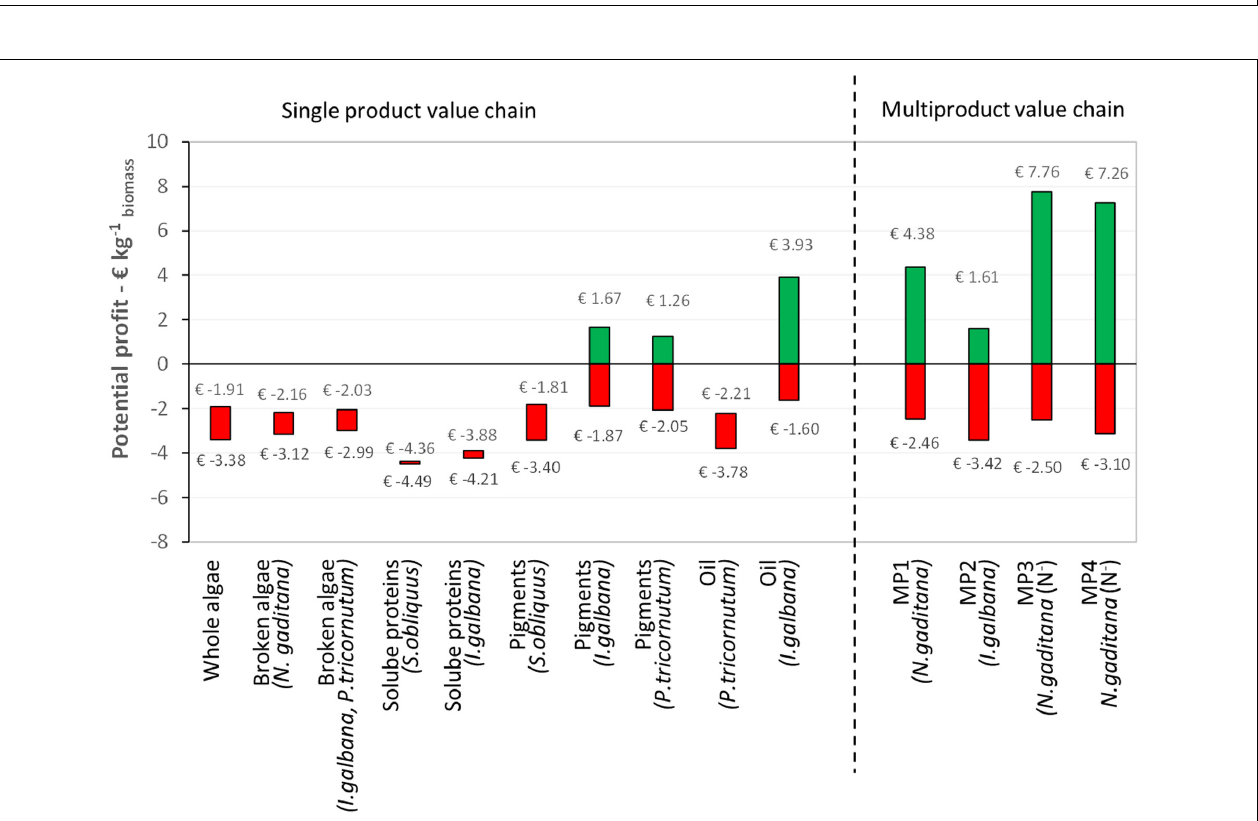
FIGURE 9 | Potential profit expressed per unit of initial biomass for the single and multiproduct value chains at 10 ktons y - 1 scale, based on the total production costs (including CO 2 capture, cultivation, and biorefinery) and the potential revenues. MP, multiproduct value chain.